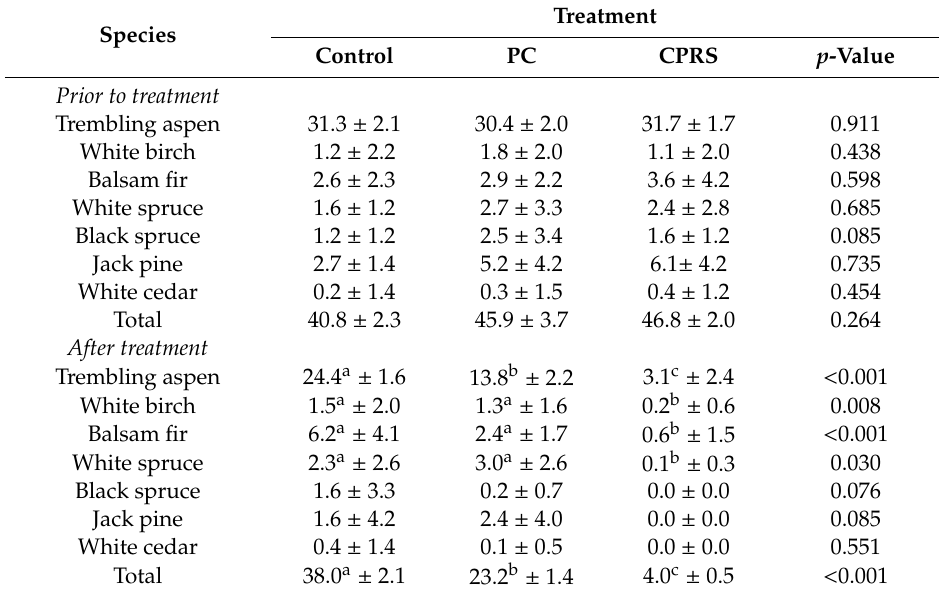
Table 2. Mean merchantable stem (DBH ≥ 9.1 cm) basal area (m 2 ha − 1 ± Standard error) across treatments and species prior to and after treatment in the studied boreal mixed-wood stands. On a given line, values with di ff erent letters di ff er significantly based on Tukey HSD comparisons ( α =